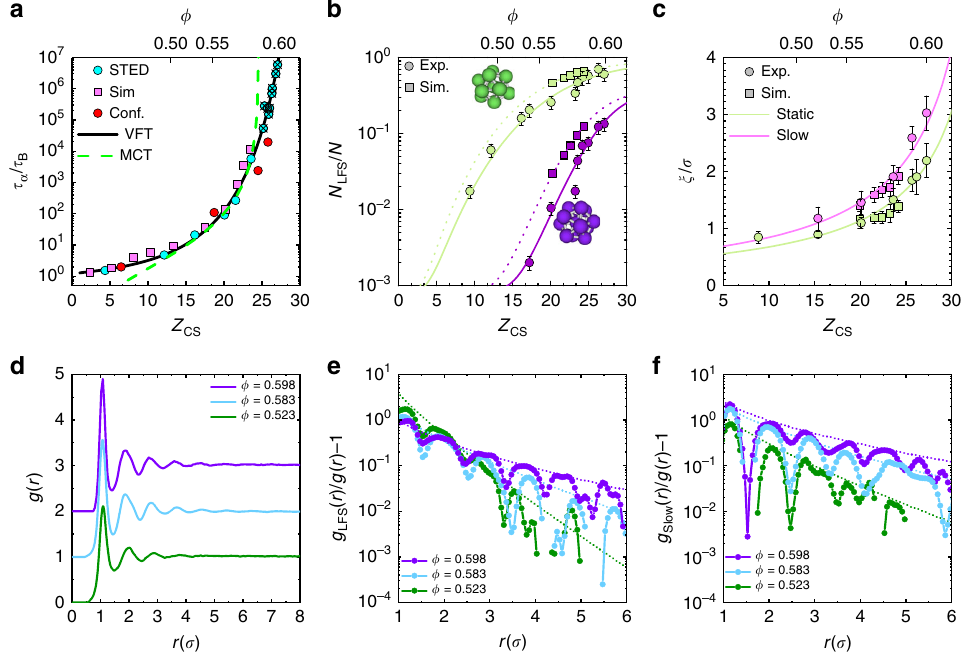
Fig. 2 Structure and dynamics at deep supercooling. a Structural relaxation time in terms of Brownian time as a function of the reduced pressure Z and volume fraction ϕ for STED, confocal 44 and simulations 40 . Key volume fractions are indicated on the top axis. Solid black line is a Vogel – Fulcher – Tammann fi t to STED data (see text for details). Dashed green line is a power law fi t from mode-coupling theory 1 . Crosses indicate state points equilibrated beyond the avoided mode-coupling transition. b Locally favoured structure populations from hard sphere experiments and simulations. Data and structures shown are 10-membered defective icosahedra (green) and 13-membered icosahedra (purple). Solid and dashed lines are a guide to the eye. Error bars correspond to standard deviation. c Static and dynamic lengthscales ξ static and ξ slow obtained for defective icosahedra and slow-moving particles respectively. Solid lines are fi tted using Eq. (2). Error bars correspond to standard deviation. d Radial distribution function g ( r ) for sample state points at weak supercooling, close to the mode-coupling crossover and at deeper supercooling. Curves are offset for clarity. e g LFS ( r ), the spatial correlation of locally favoured structure and f g slow ( r ), the spatial correlation of immobility (Methods section) divided by g ( r ) for the same state points as d . Dotted lines are fi ts of the Ornstein – Zernike envelope function Eq. (5)